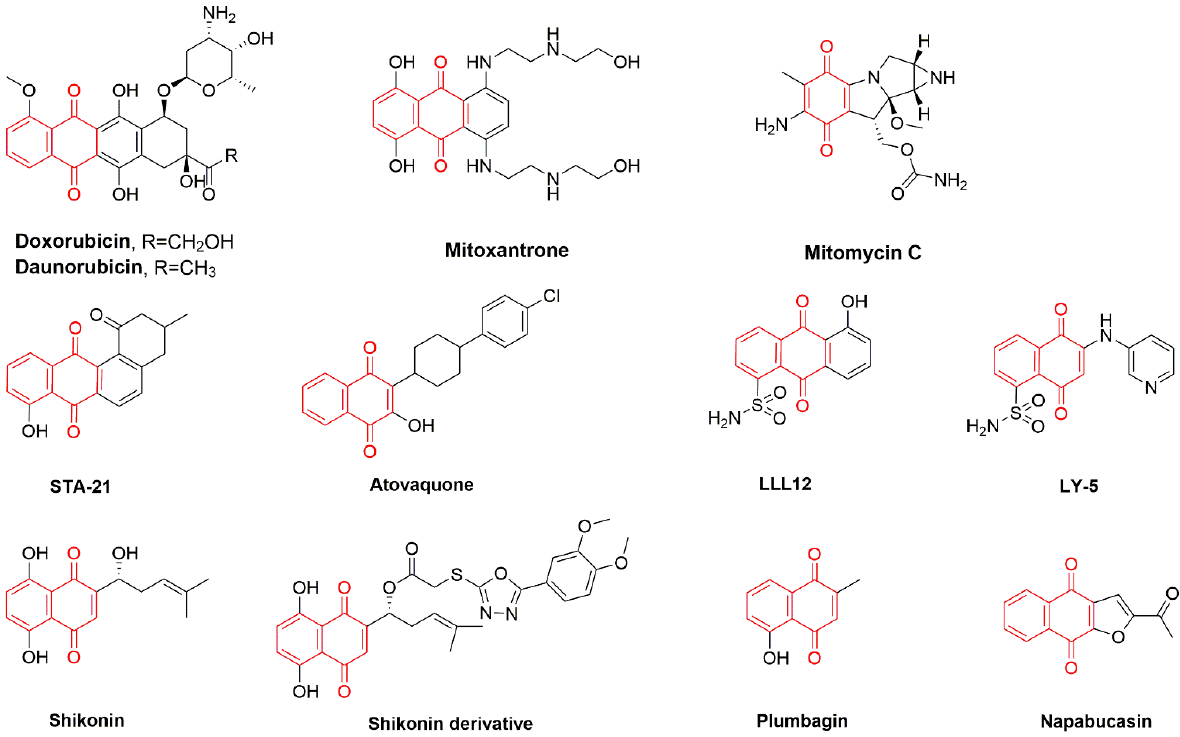
Figure 1. Representative antitumor compounds with quinone scaffolds.